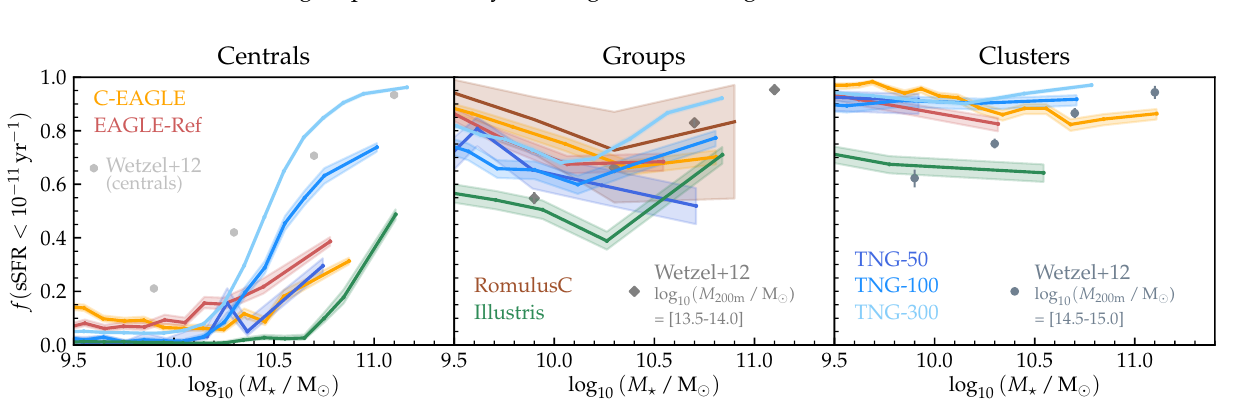
10 14 M , ( middle )) and − (cid:12) 0) and ≈